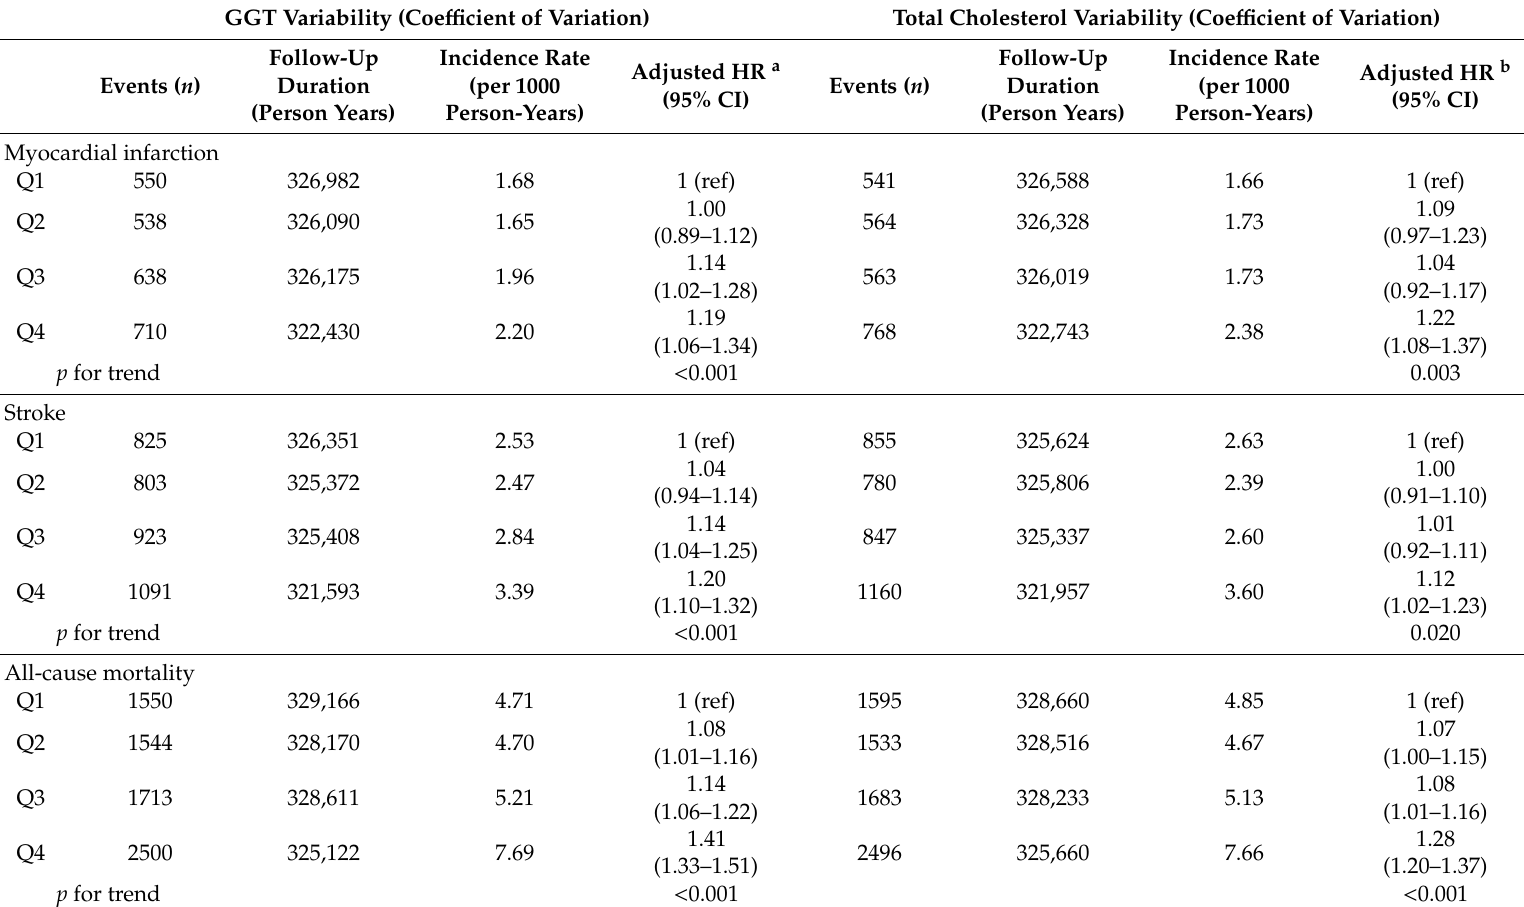
Table 2. Hazard ratios and 95% confidence intervals for myocardial infarction, stroke, all-cause mortality, and cardiovascular disease-related mortality by quartiles of γ -glutamyltransferase (GGT) variability (coe ffi cient of variation) and total cholesterol variability (coe ffi cient of